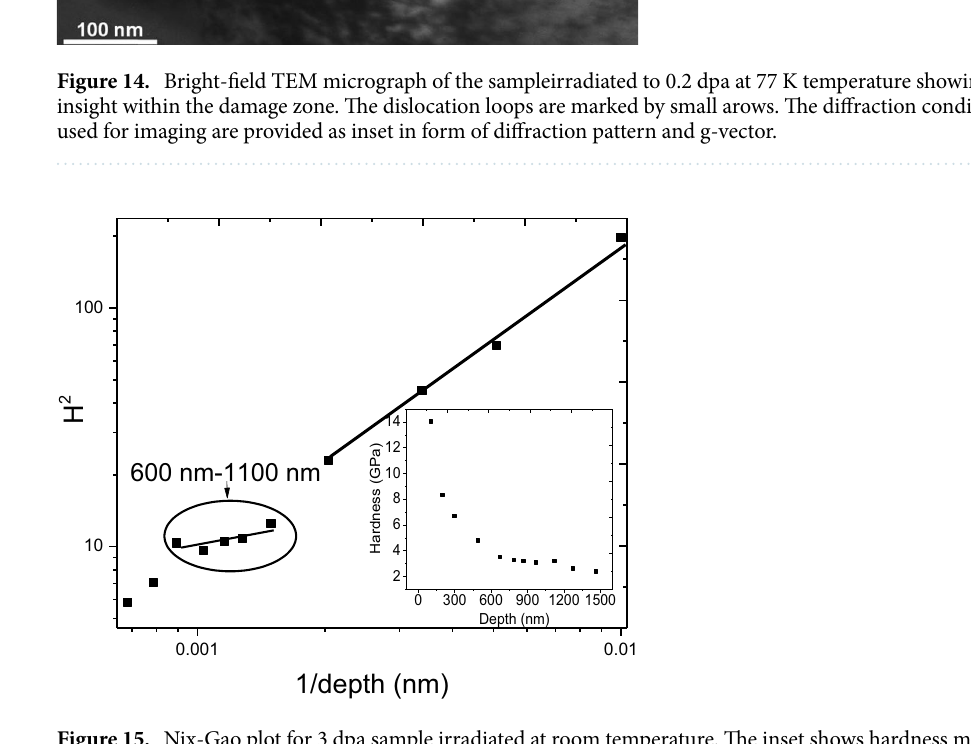
Figure 15. Nix-Gao plot for 3 dpa sample irradiated at room temperature. The inset shows hardness measured as a function of depth from the implanted